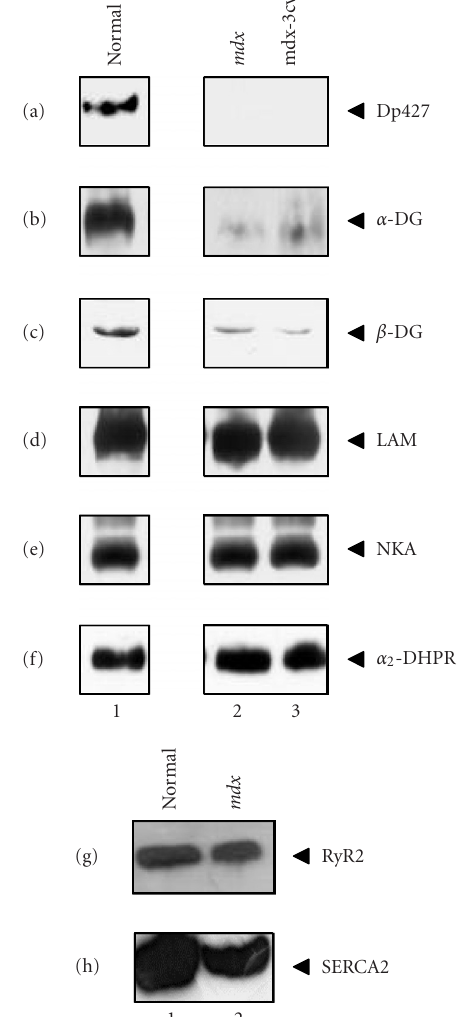
Figure 1. Reduced expression of the dystroglycan complex in dystrophic heart membranes. Shown are immunoblots of nor- mal (lane 1), 15-week-old mdx (lane 2), and 15-week-old mdx - 3cv (lane 3) cardiac muscle membranes, labelled with antibod- ies to the Dp427 isoform of dystrophin (a), α -dystroglycan ( α - DG) (b), β -dystroglycan ( β -DG) (c), laminin (LAM) (d), the α -subunit of the Na + /K + -ATPase (NKA) (e), the α 2 -subunit of the dihydropyridine receptor ( α 2 -DHPR) (f), the RyR2 iso- form of the ryanodine receptor Ca 2+ release channel (g), and the slow/cardiac SERCA2 isoform of the sarcoplasmic reticu- lum Ca 2+ -ATPase (h). Dystrophin-deficient cardiac microsomes clearly exhibit a drastic reduction in both